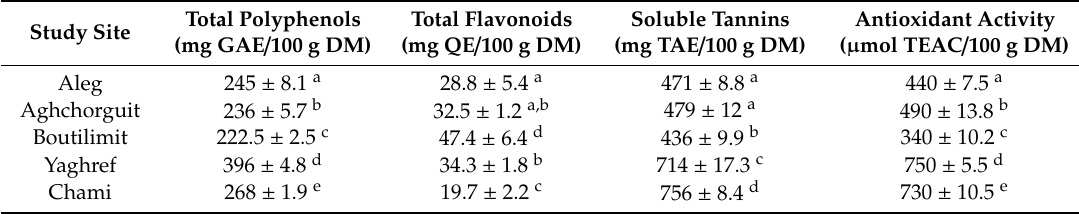
Table 3. Means ± standard deviation of bioactive compounds and antioxidant activity of B. aegyptiaca fruit pulp from 5 locations in Mauritania, Northwest